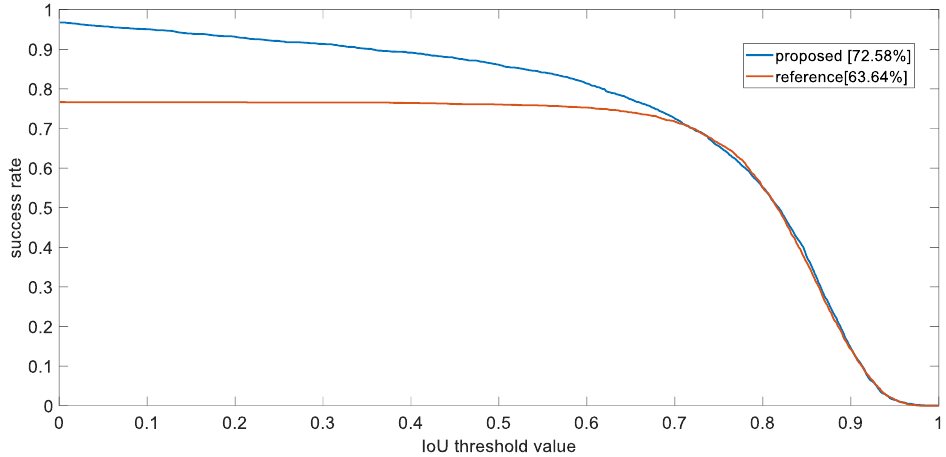
Figure 6. The success plot of the proposed tracking method and compared system.